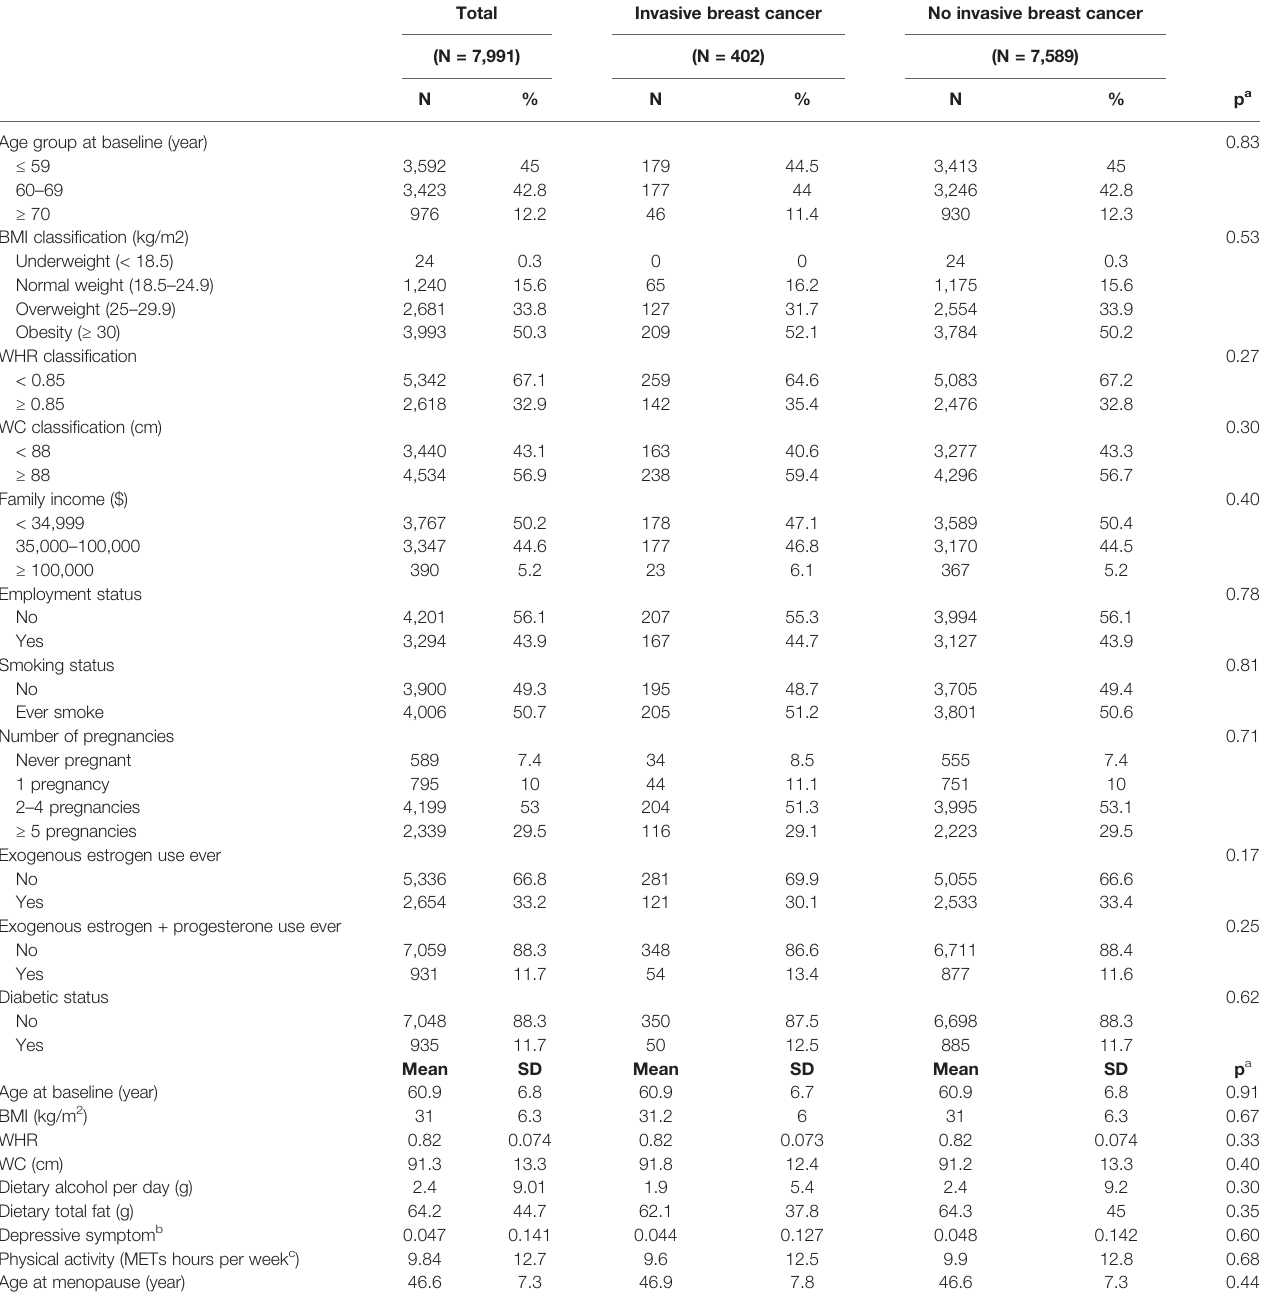
TABLE 1 | Characteristics of participants by invasive breast cancer status. Total Invasive breast cancer No invasive breast